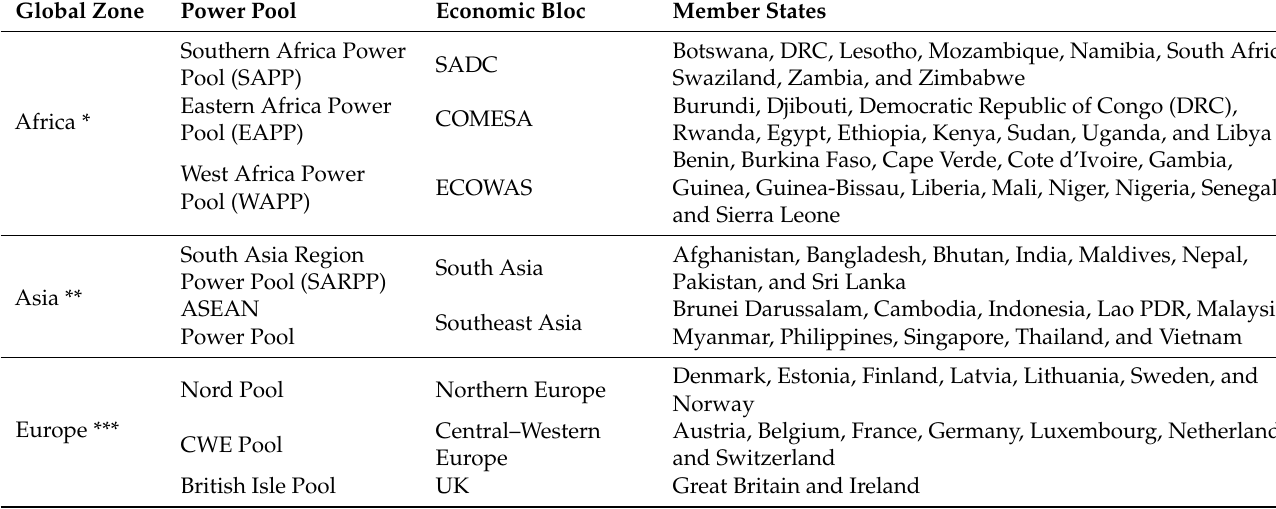
Table 9. Some of the existing power pools